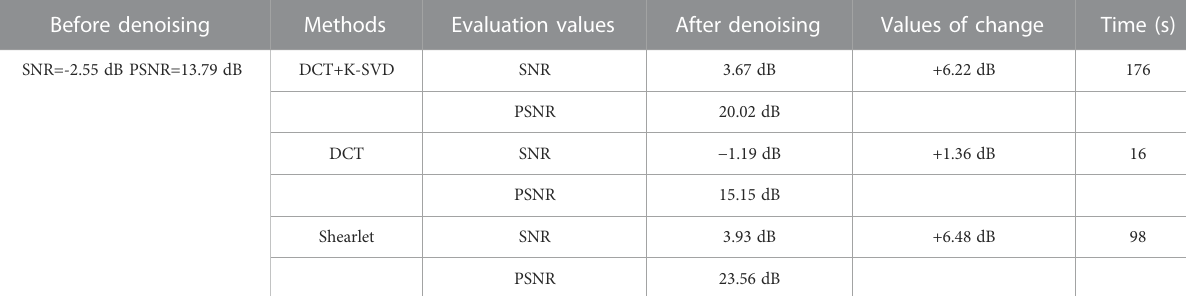
TABLE 3 Evaluation values for different methods. Before